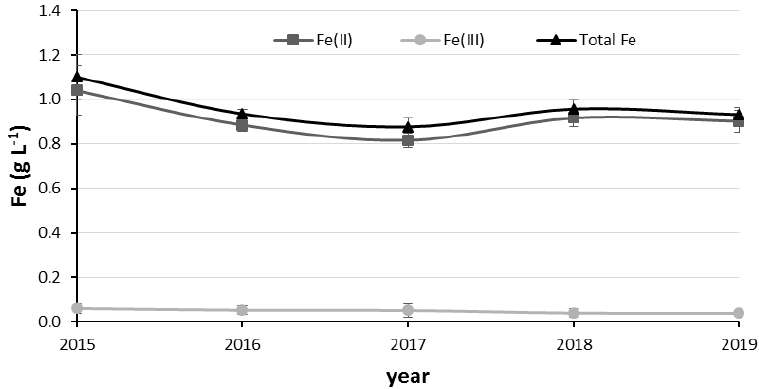
Figure 5. Annual trend of Fe species and total Fe concentration in copper electrolyte from 2015 to 2019.